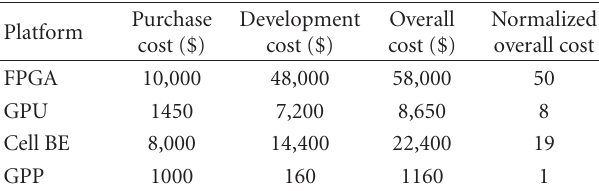
Table 5: Development times of the Smith-Waterman algorithm implementation on all four technologies.